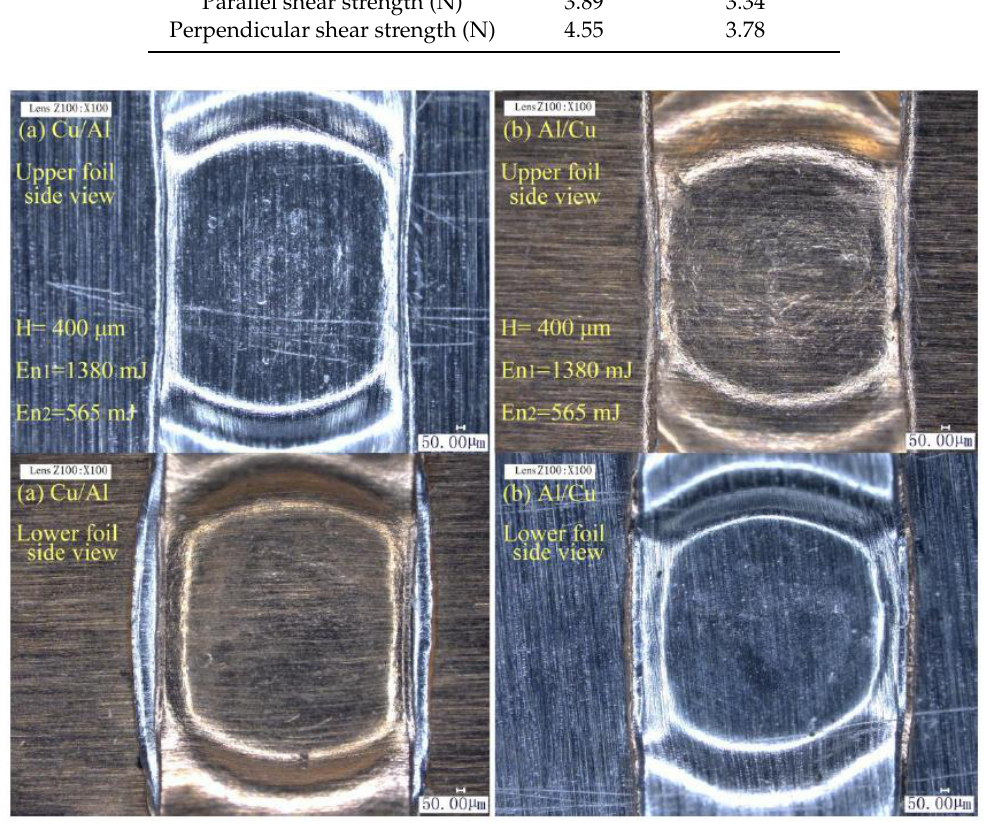
Figure 29. The joints produced by micro-shearing clinching: ( a ) Cu/Al; ( b ) Al/Cu.